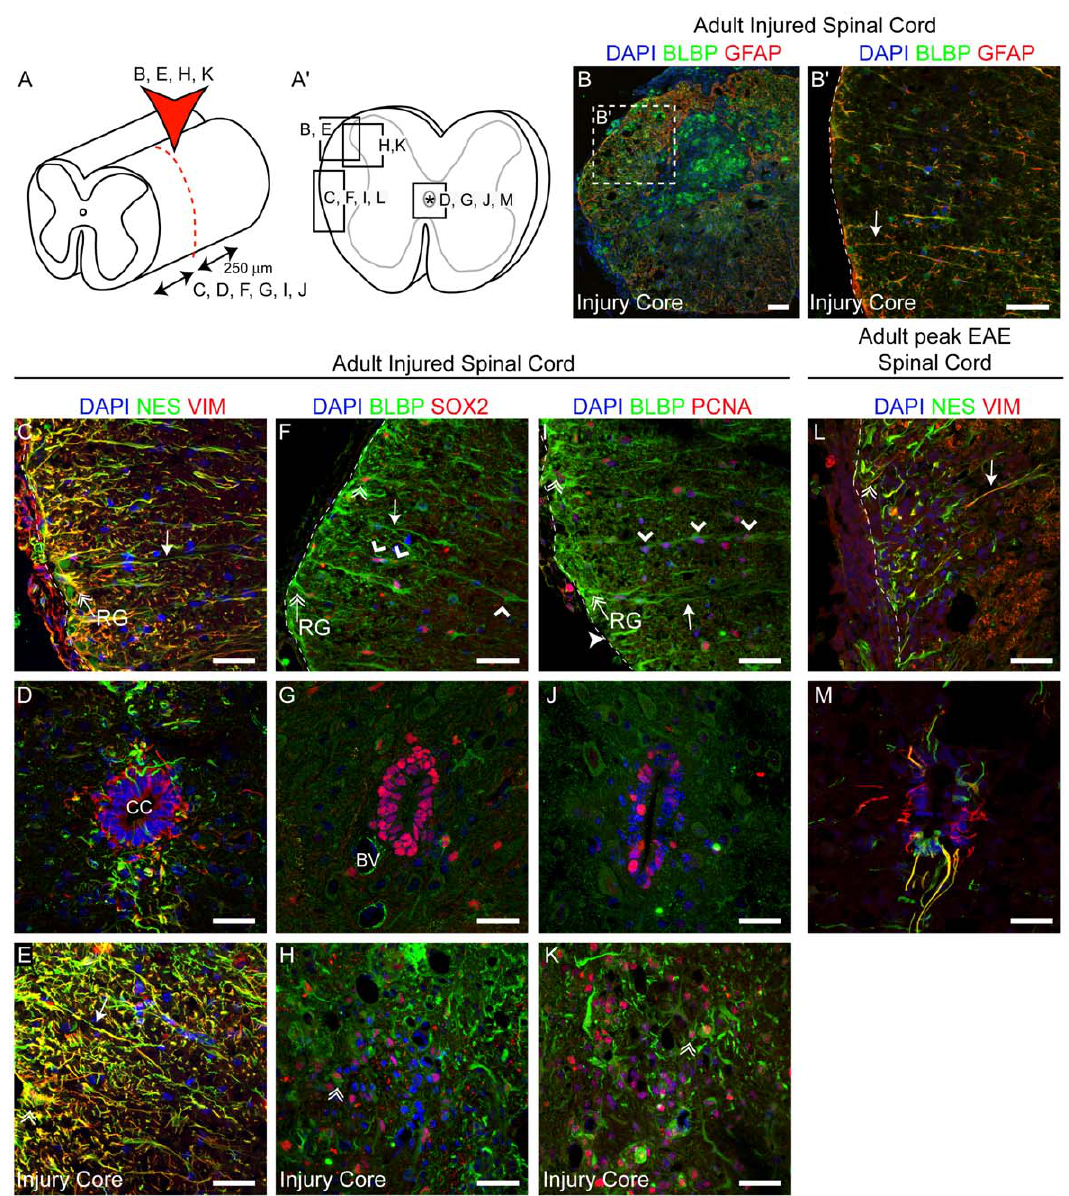
Figure 7. Spinal Cord Radial Glia Expand and Transform Morphologically During the Response to SC Compression and Experimental Autoimmune Encephalomyelitis. Confocal z-stack images of an adult SC reveal similar responses by SCRG and CC progenitors 14 days after a (A) dorsal column compression (red arrowhead), where analysis was performed both (B, B 9 , E, H, K) at the injury core and (C, D, F, G, I, J) peri-lesion area ( # 250 m m rostral or caudal from the site of injury). (A 9 ) Schematic of SC cross-section detailing the position of (B 9 –M) images (B–B 9 ) After dorsal column compression BLBP + /GFAP + SCRG appear disorganized but their processes are readily detected. In the peri-lesion area, SCRG processes appear hypertrophied and strongly express (C–E) NES (green) and VIM (red). Nuclei containing (F–H) SOX2 or (I–K) PCNA are more abundant after lesion in all locations - at the pial boundary, arrayed along BLBP + (green) processes and (G, J) at the CC. (L–M) Analysis of expression following the induction of EAE showed a similar profile of SCRG hypertrophy and CC expansion. CC: Central Canal; arrow: process; double arrowhead: double-positive cell; double arrow: SCRG; open arrowhead: cell on SCRG process; dotted line: marginal edge of SC Scale bars: 100 m m (A), and 50 m m (A 9